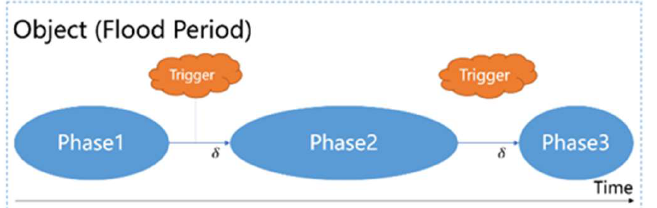
Figure 6. Schematic diagram of presentation results of phase-level dynamic expression class.